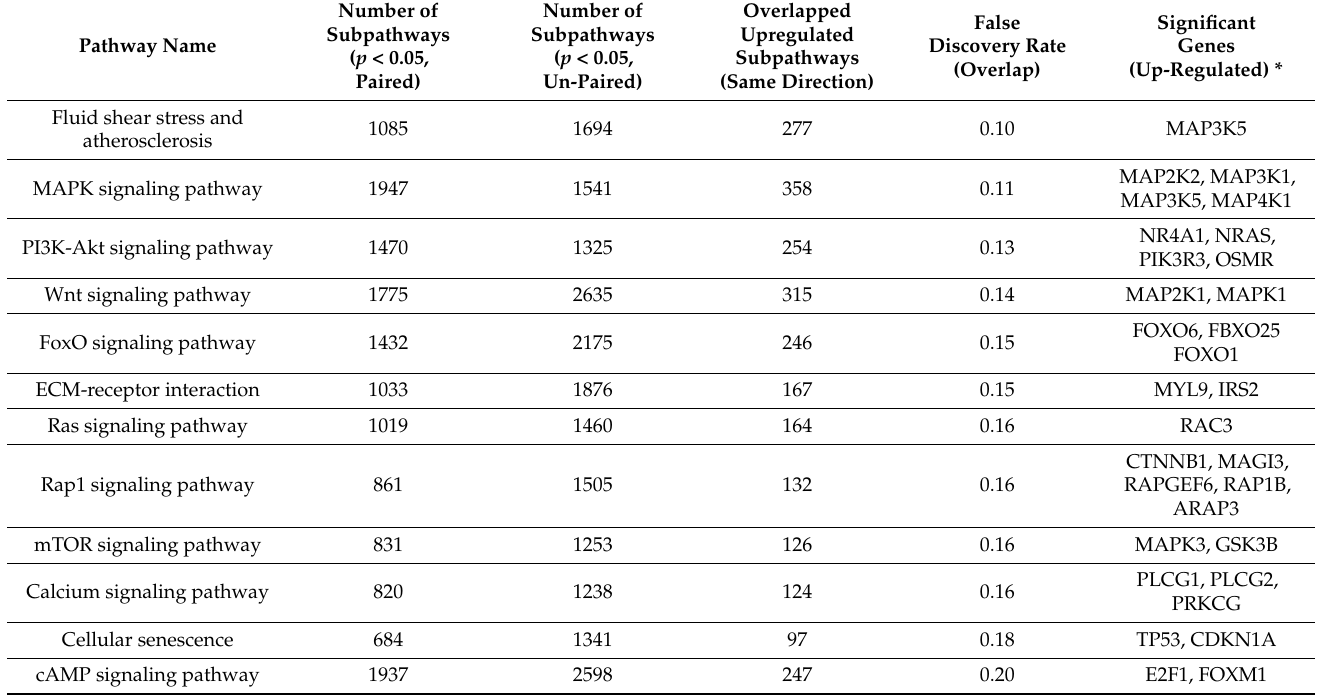
Table 5. Significantly upregulated subpathways and their associated genes in both paired and unpaired drug-resistant breast cancer